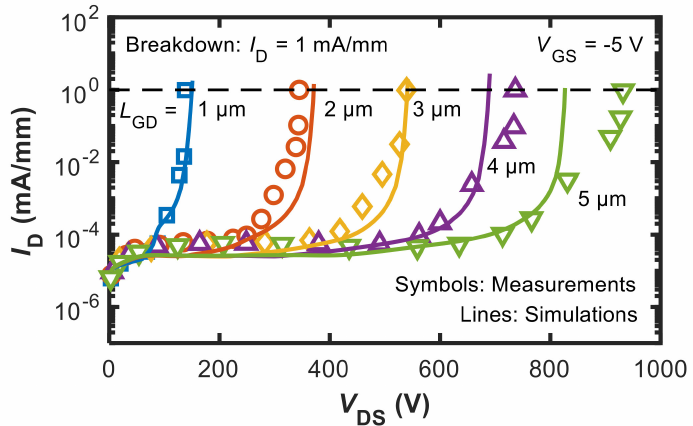
Figure 2. Calibrated simulations (lines) and measurements (symbols) of the off-state I D – V DS curves. Measured data are taken from [1]. Adapted from [14].